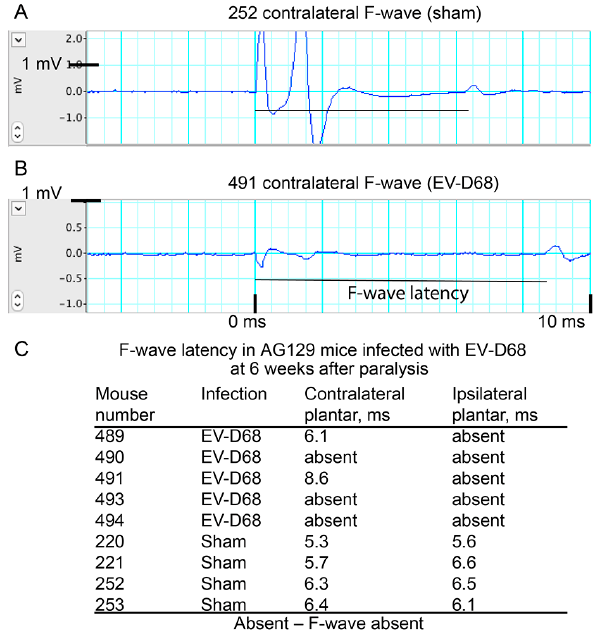
Figure 4. F-wave tracings and latency stimulated at popliteal nerve behind knee and recorded at plantar muscles from AG129 mice infected with EV-D68 six weeks after onset of paralysis. ( A ) F-wave of contralateral hindlimb of #252 sham mouse; ( B ) F-wave of contralateral hindlimb of #491 EV-D68-infected mouse; ( C ) F-wave latencies among EV-D68-infected and sham-infected mice.